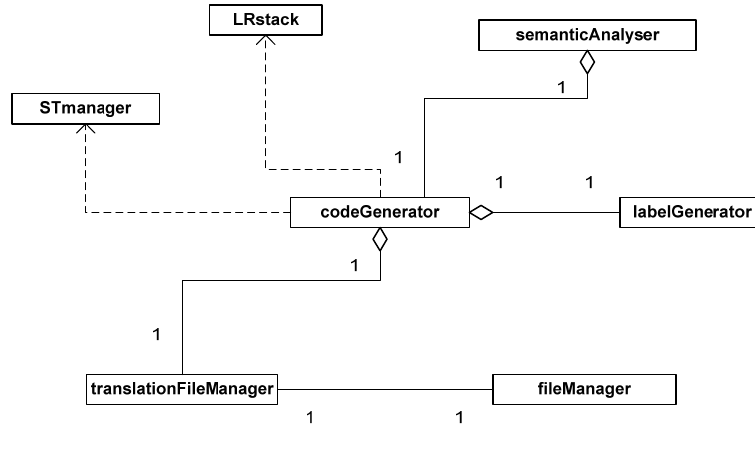
Figure 5. Simplified code generator class diagram.